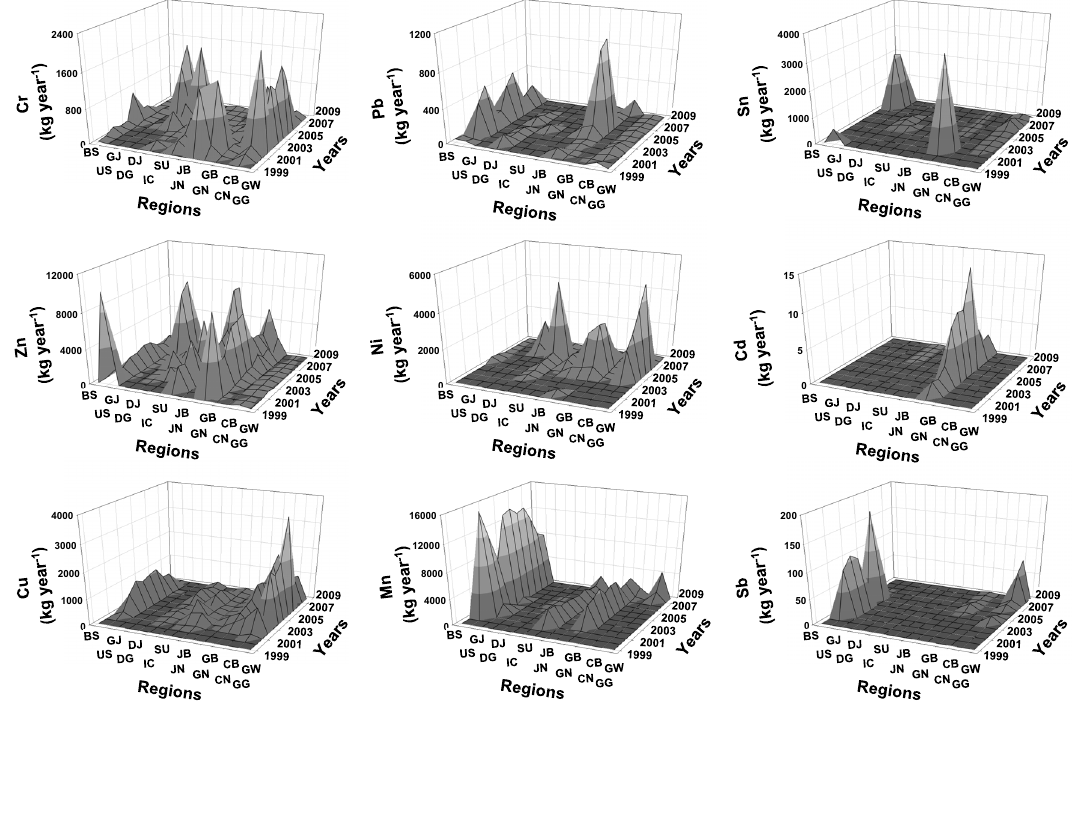
Figure 3. Changes of effluents of nine heavy metals in different regions from 1999 to 2010. GG: Gyeonggi, GW: Gangwon, CB: Chungbuk, CN: Chungnam, GB: Gyeongbuk, GN: Gyeongnam, JB: Jeonbuk, JN: Jeonnam, SU: Seoul, IC: Inchon, DJ: Daejoen, DG: Daegu, GJ: Gwangju, US: Ulsan, and BS: